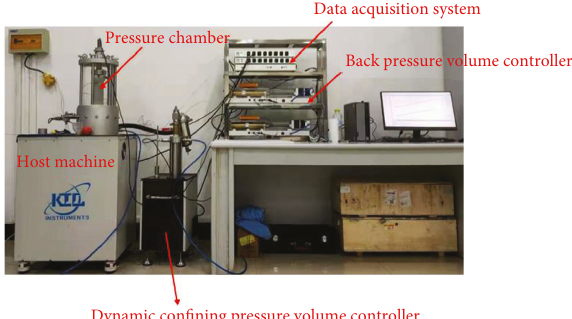
Figure 1: Composition of KTL dynamic triaxial